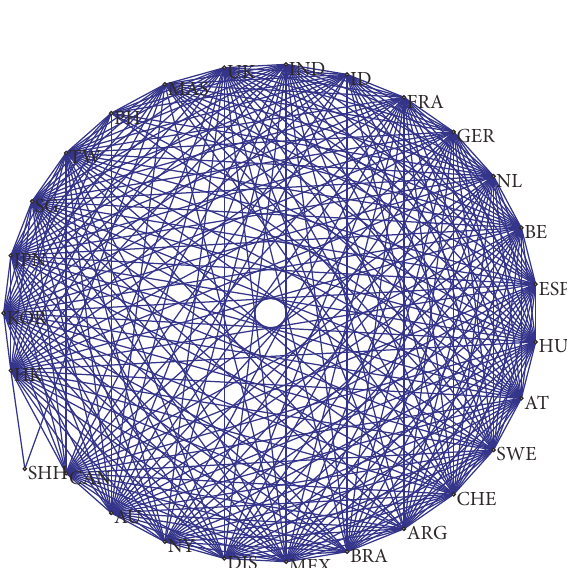
Figure 13: Topology graph of ISMN in 2001–2012.